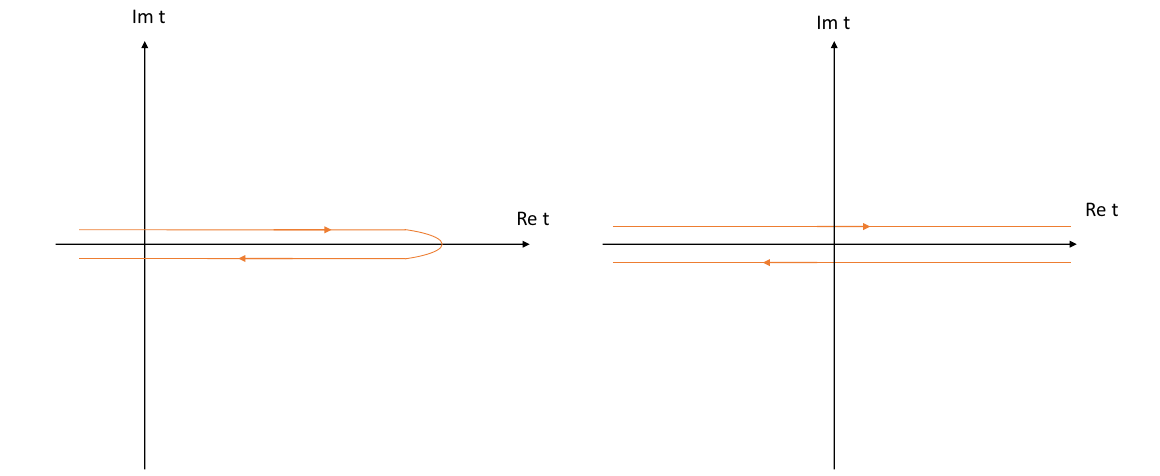
Fig. 2 Schwinger–Keldysh contours with finite and infinite initial and final